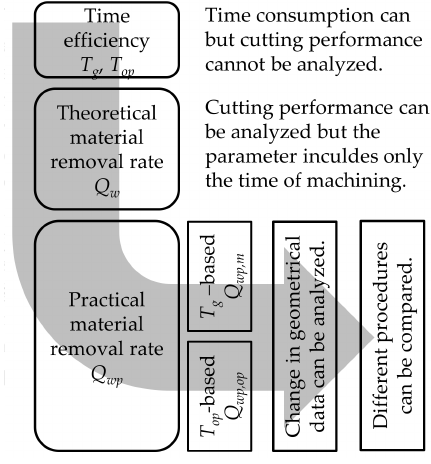
Figure 1. Logic of the